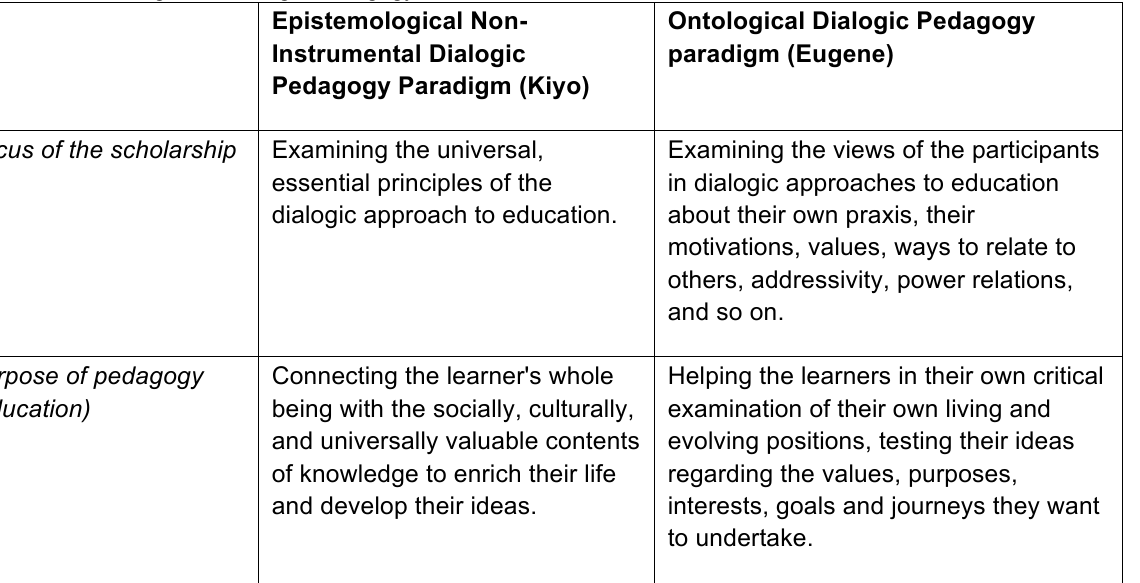
Table 1: Two Paradigms of Dialogic